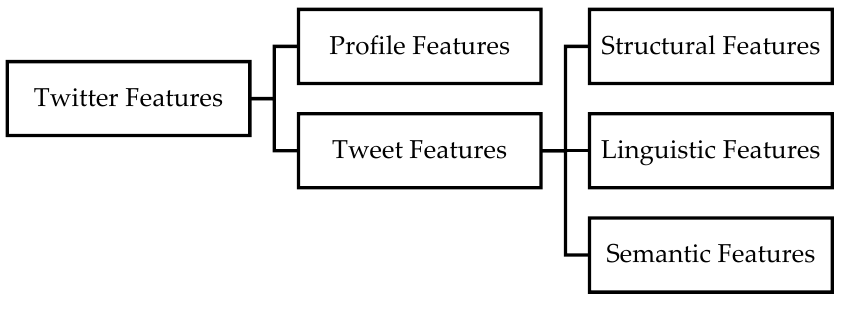
Figure 2. Categories of Twitter features .